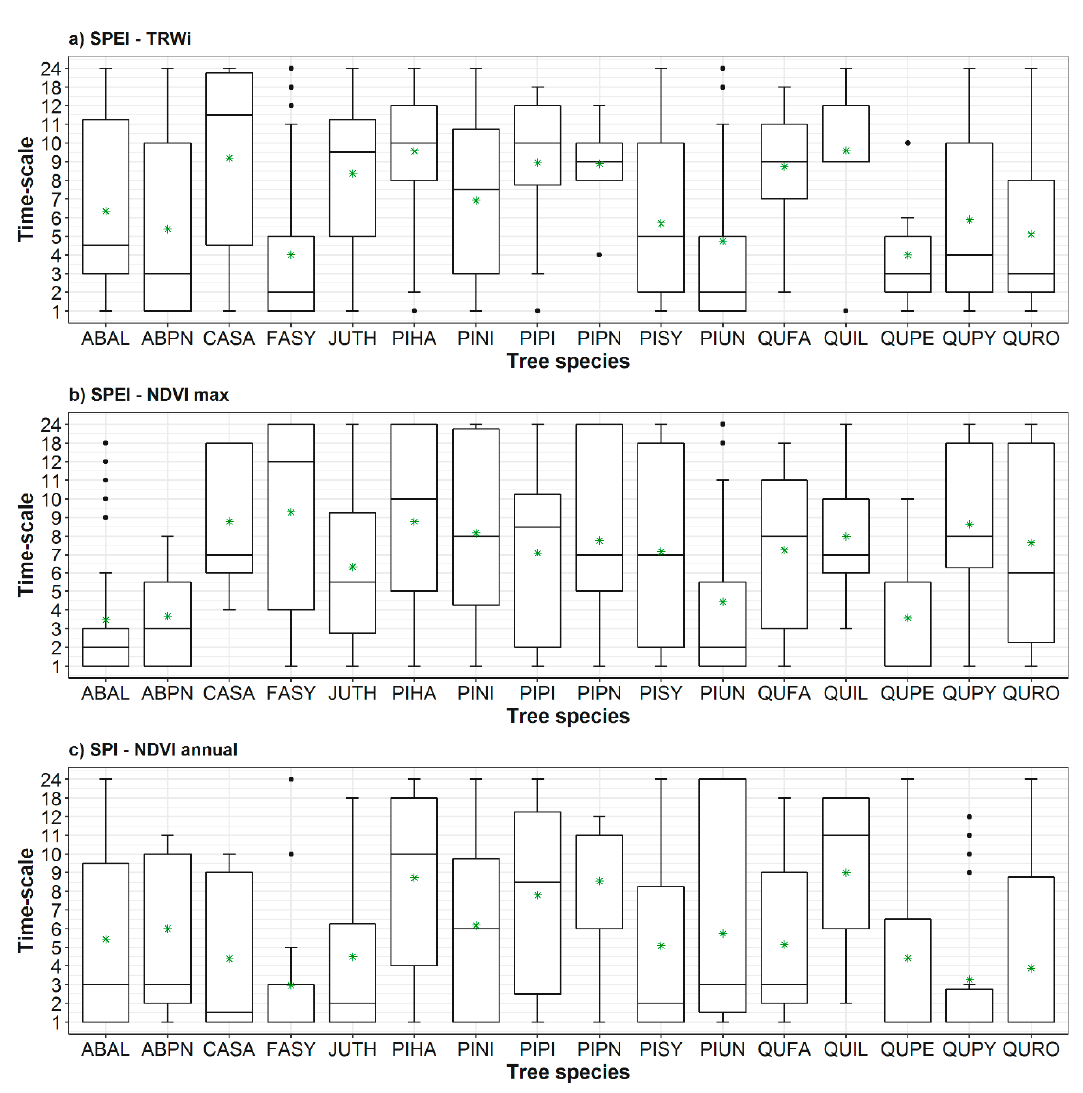
Figure 6. Box plots showing the most correlated timescale found for ring-width indices (TRWi, ( a )), NDVI max ( b ), NDVI annual ( c ), and the most correlated drought index. The solid black line corresponds to the median, green asterisks mark the means. Species’ codes correspond to those listed in Table 1.